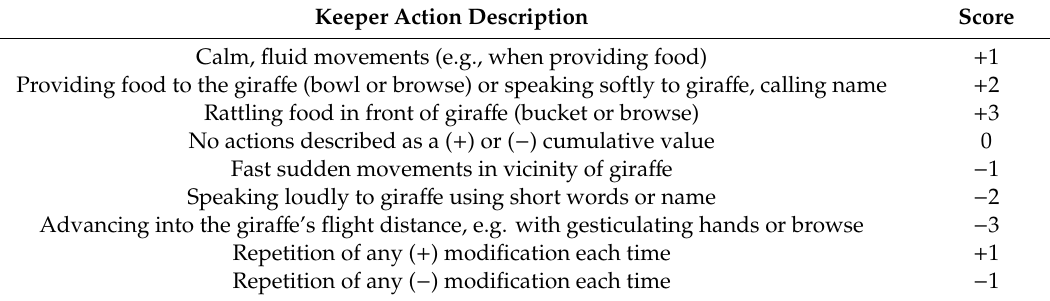
Table 3. Keeper actions and scores used by keepers to slightly alter the initial keeper-animal interaction event to increase or decrease the performance of the desired behaviour. Method adapted for gira ff e from Ward and Melfi